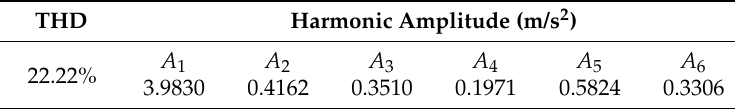
Table 3. Total harmonic distortion analysis result.